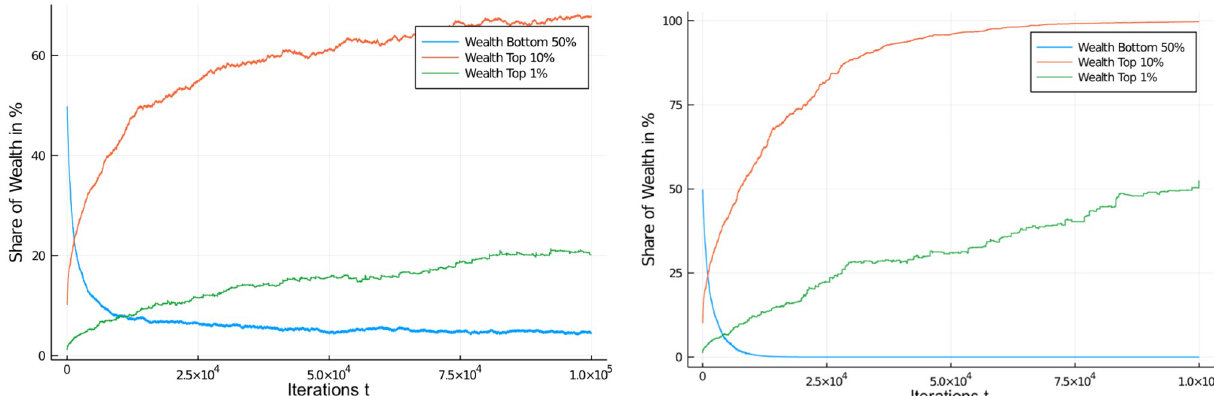
Fig 6. Comparison of redistribution effects. Wealth development in different quantiles of the population of 1,000 agents. Flat income tax regime, with regular flat tax of 30%. Comparison of income tax application with redistribution to all, case I (left) and baseline case, untaxed (right). Initial distribution was equal among all 1,000 agents. Quantiles shown: Bottom half of the population vs top 10% and top 1% wealthiest agents.